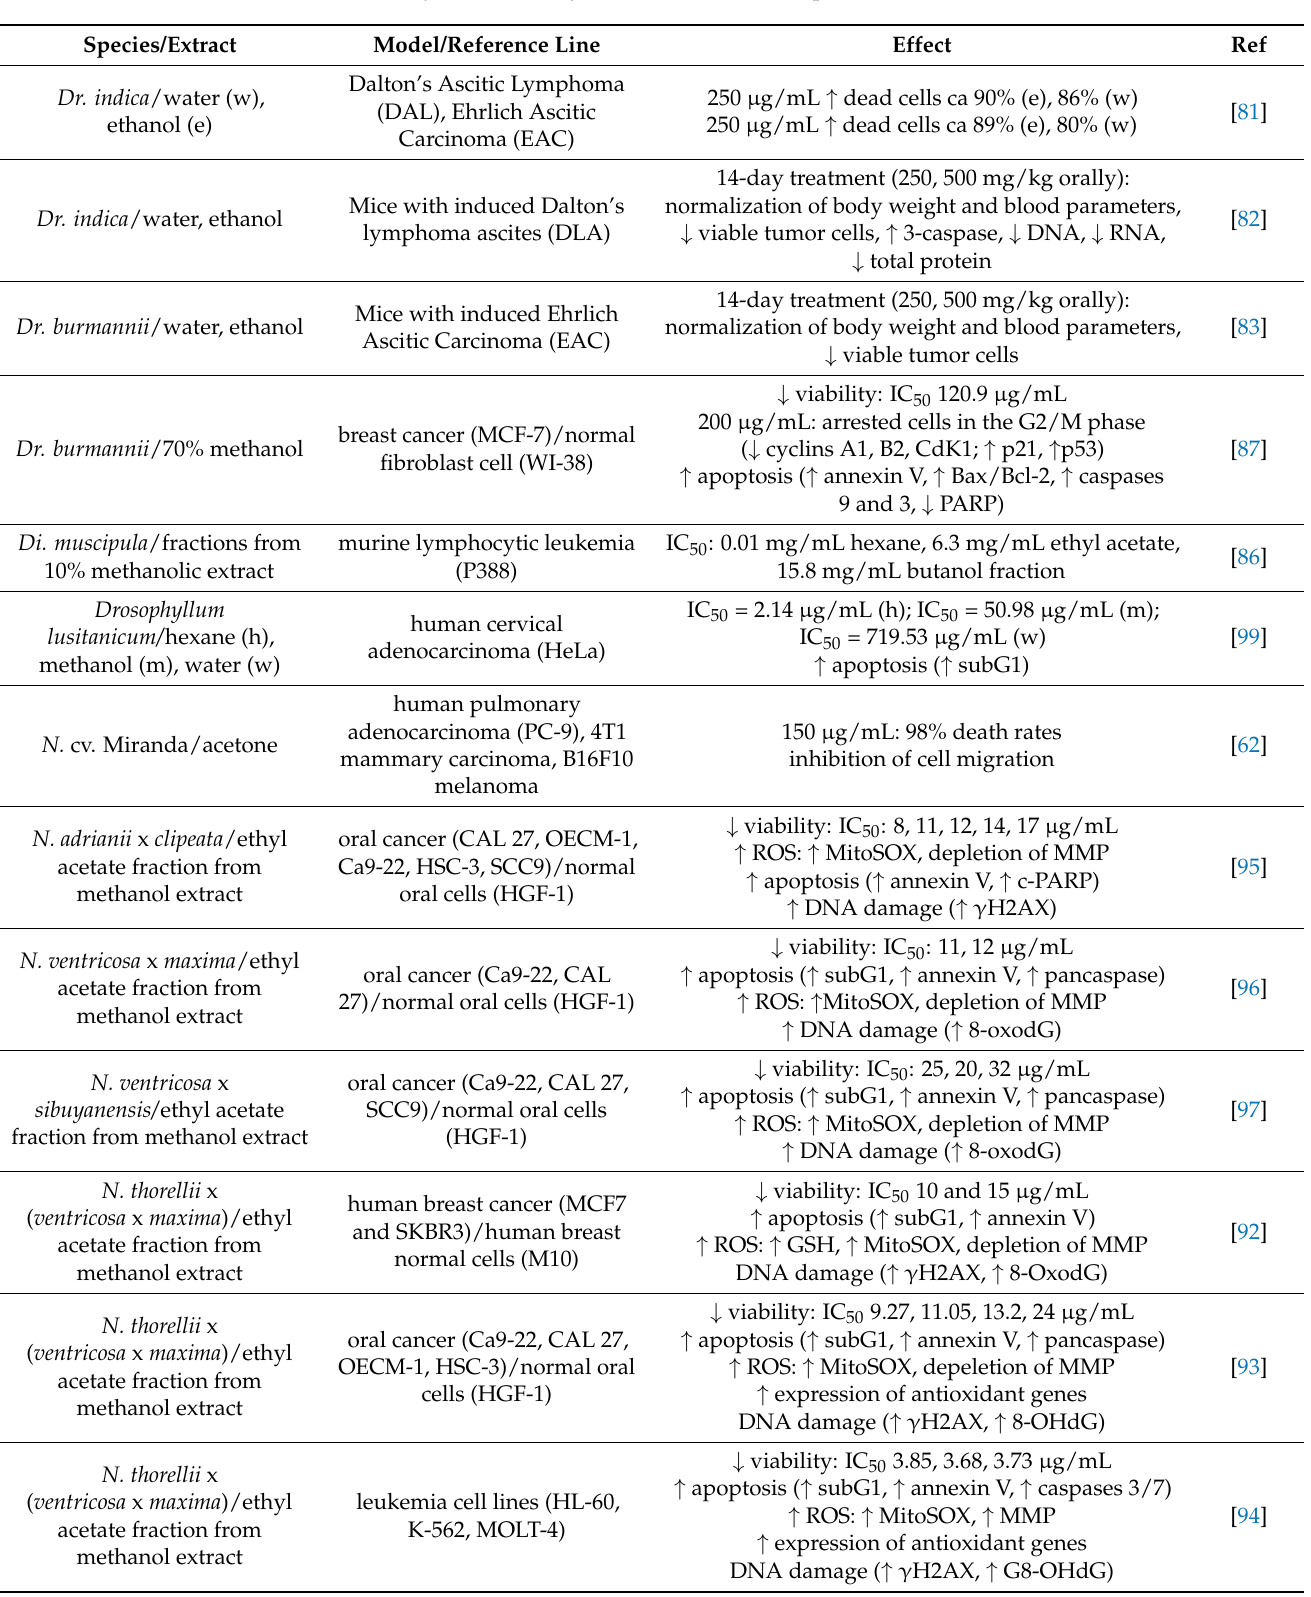
Table 3. Cytotoxic activity of Droseraceae and Nepenthaceae